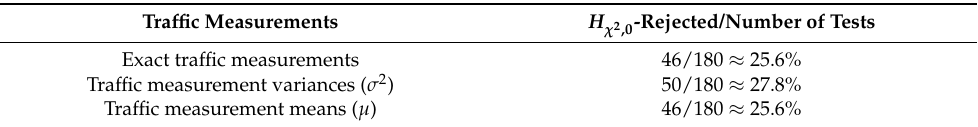
Table 15. H χ 2 ,0 rejection ratios for exact traffic measurements (i.e., counts), traffic measurement variances, and traffic measurement